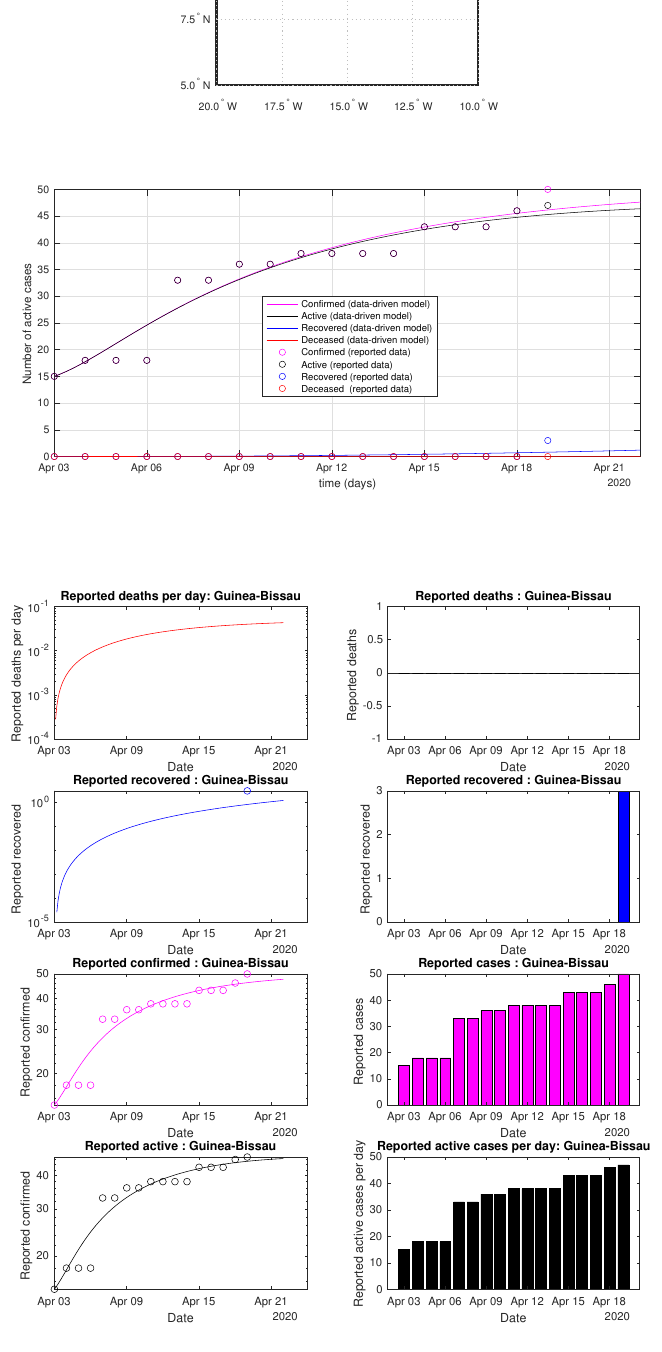
Figure 66. Guinea-Bissau: data vs.